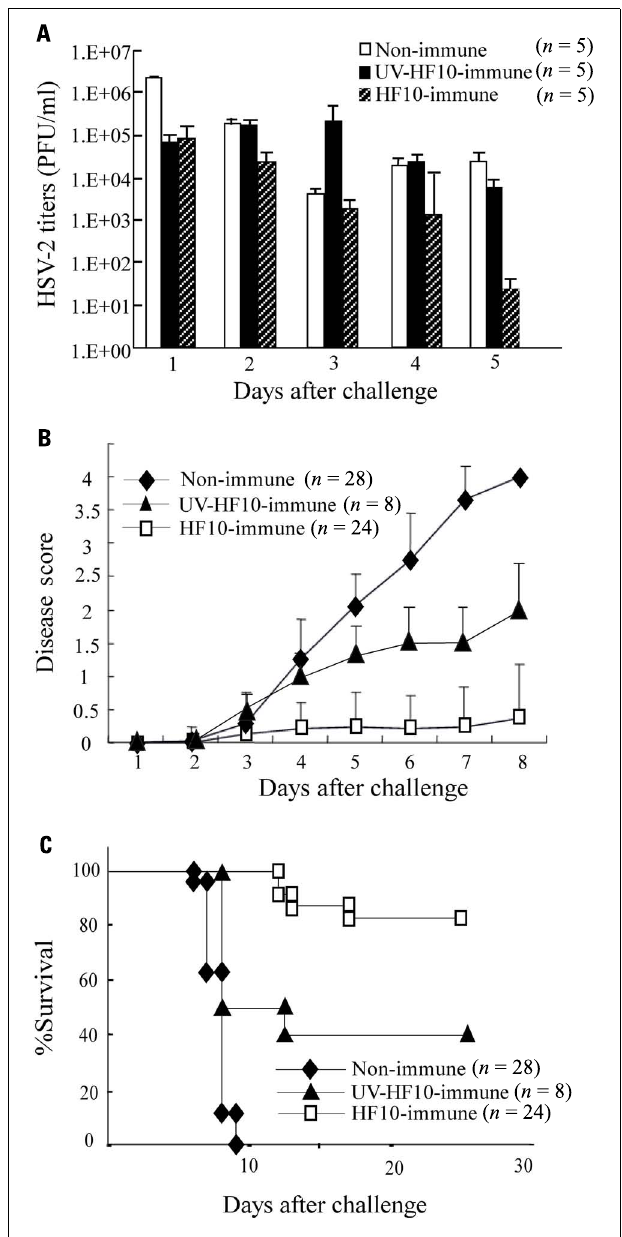
FIGURE 2 | Immunization of mice with HF10 followed by lethal HSV-2 challenge via vaginal inoculation. One month after immunization with HF10, 5 × 10 5 PFUs of wild-type HSV-2 strain 186 were inoculated into mice vagina. Unimmunized mice and UV-inactivated HF10-immunized mice were used as controls. (A) Replication of strain 186 in the genital mucosa was determined by viral titrations of vaginal washes (200 μ l).Viral titers were significantly lower in HF10-immunized mice on day 5 than in both unimmunized mice ( P < 0.05) and UV-inactivated HF10-immunized mice ( P < 0.05). (B) Clinical symptoms were monitored and scored for 8 days. HF10-immunized mice had lower disease scores than unimmunized mice (on day 8, P < 0.0001). Disease scores were not significantly different between UV-inactivated HF10-immunized mice and unimmunized mice ( P = 0.065). (C) Survival curve derived by the Kaplan–Meier method. HF10-immunized mice survived longer than unimmunized mice and UV-inactivated HF10 mice (on day 28, P < 0.0001 and P = 0.001,